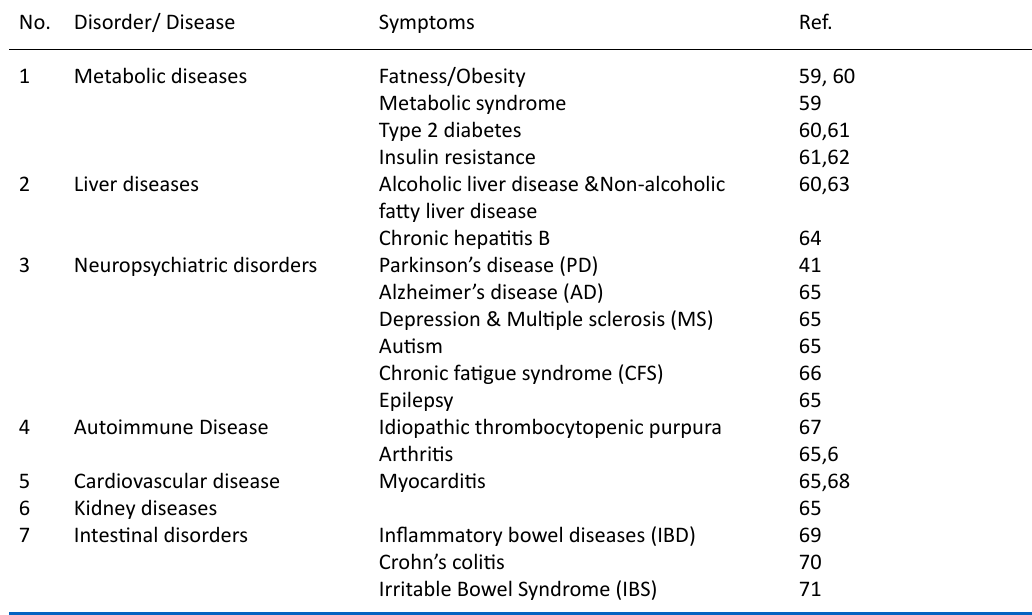
table 1. Diseases treated with FMT No. Disorder/ Disease Symptoms